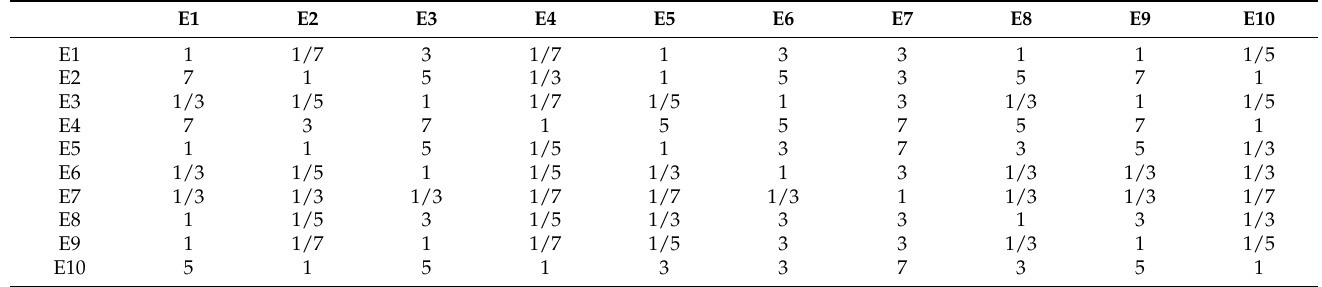
Table A5. Judgment matrix related to occurrence (O) dimension (Bogn á r and Benedek 2022a).